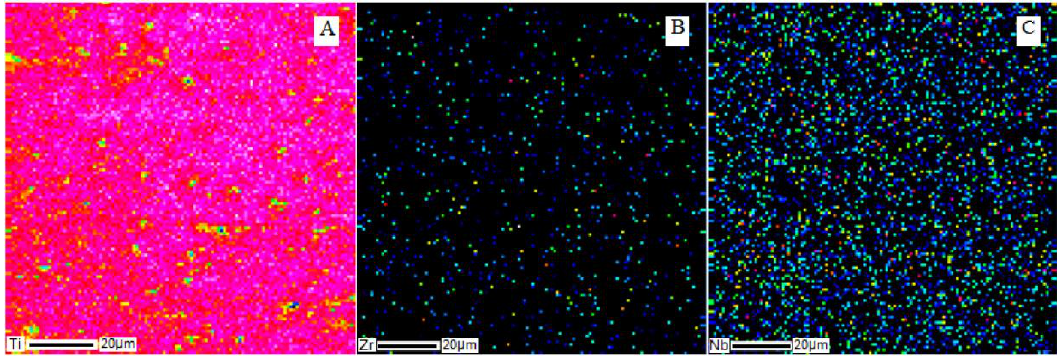
Figure 4. Elemental distribution of metals in the structure of the Ti–28Nb–5Zr alloy after annealing at 900 °C for 12 h: ( A ) titanium; ( B ) zirconium; ( C ) niobium.